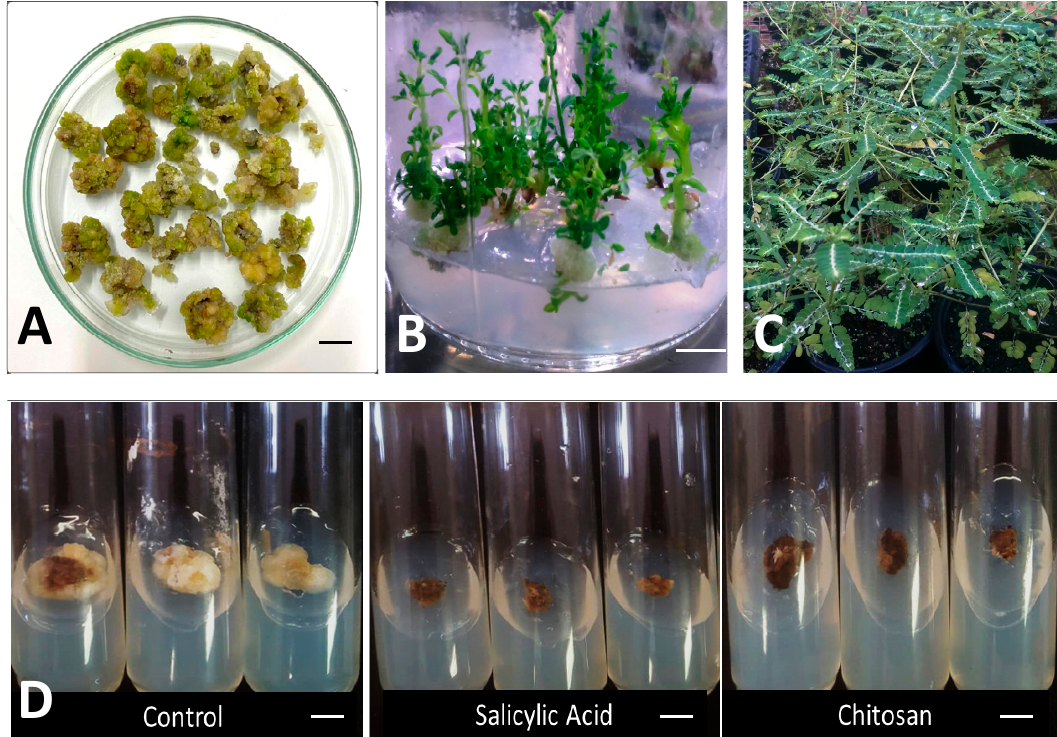
Figure 2. Green callus obtained with BA and lighting conditions ( A ); micropropagated plantlets under in vitro ( B ) and acclimatized under greenhouse conditions ( C ); effects of salicylic acid and chitosan on callus elicitation obtained with 2,4-D (0.50 mg/L) and darkness conditions ( D ) (bars = 1.0 cm). Table 3. Fresh weight of calli of Phyllanthus amarus proliferated in vitro under concentrations of 6-benziladenine.